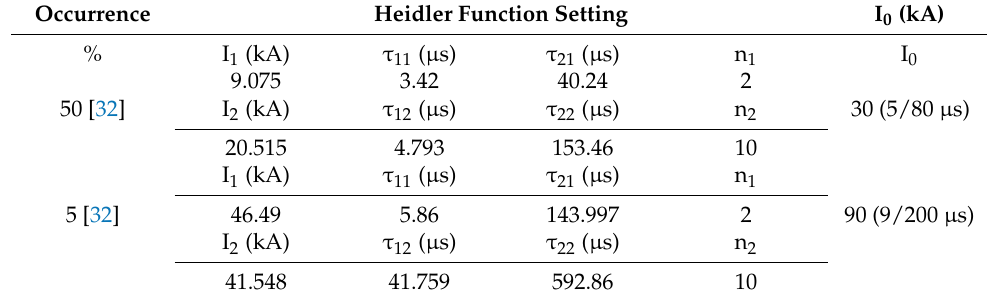
Table 1. Parameters of Heidler Function for I 0 Peak.